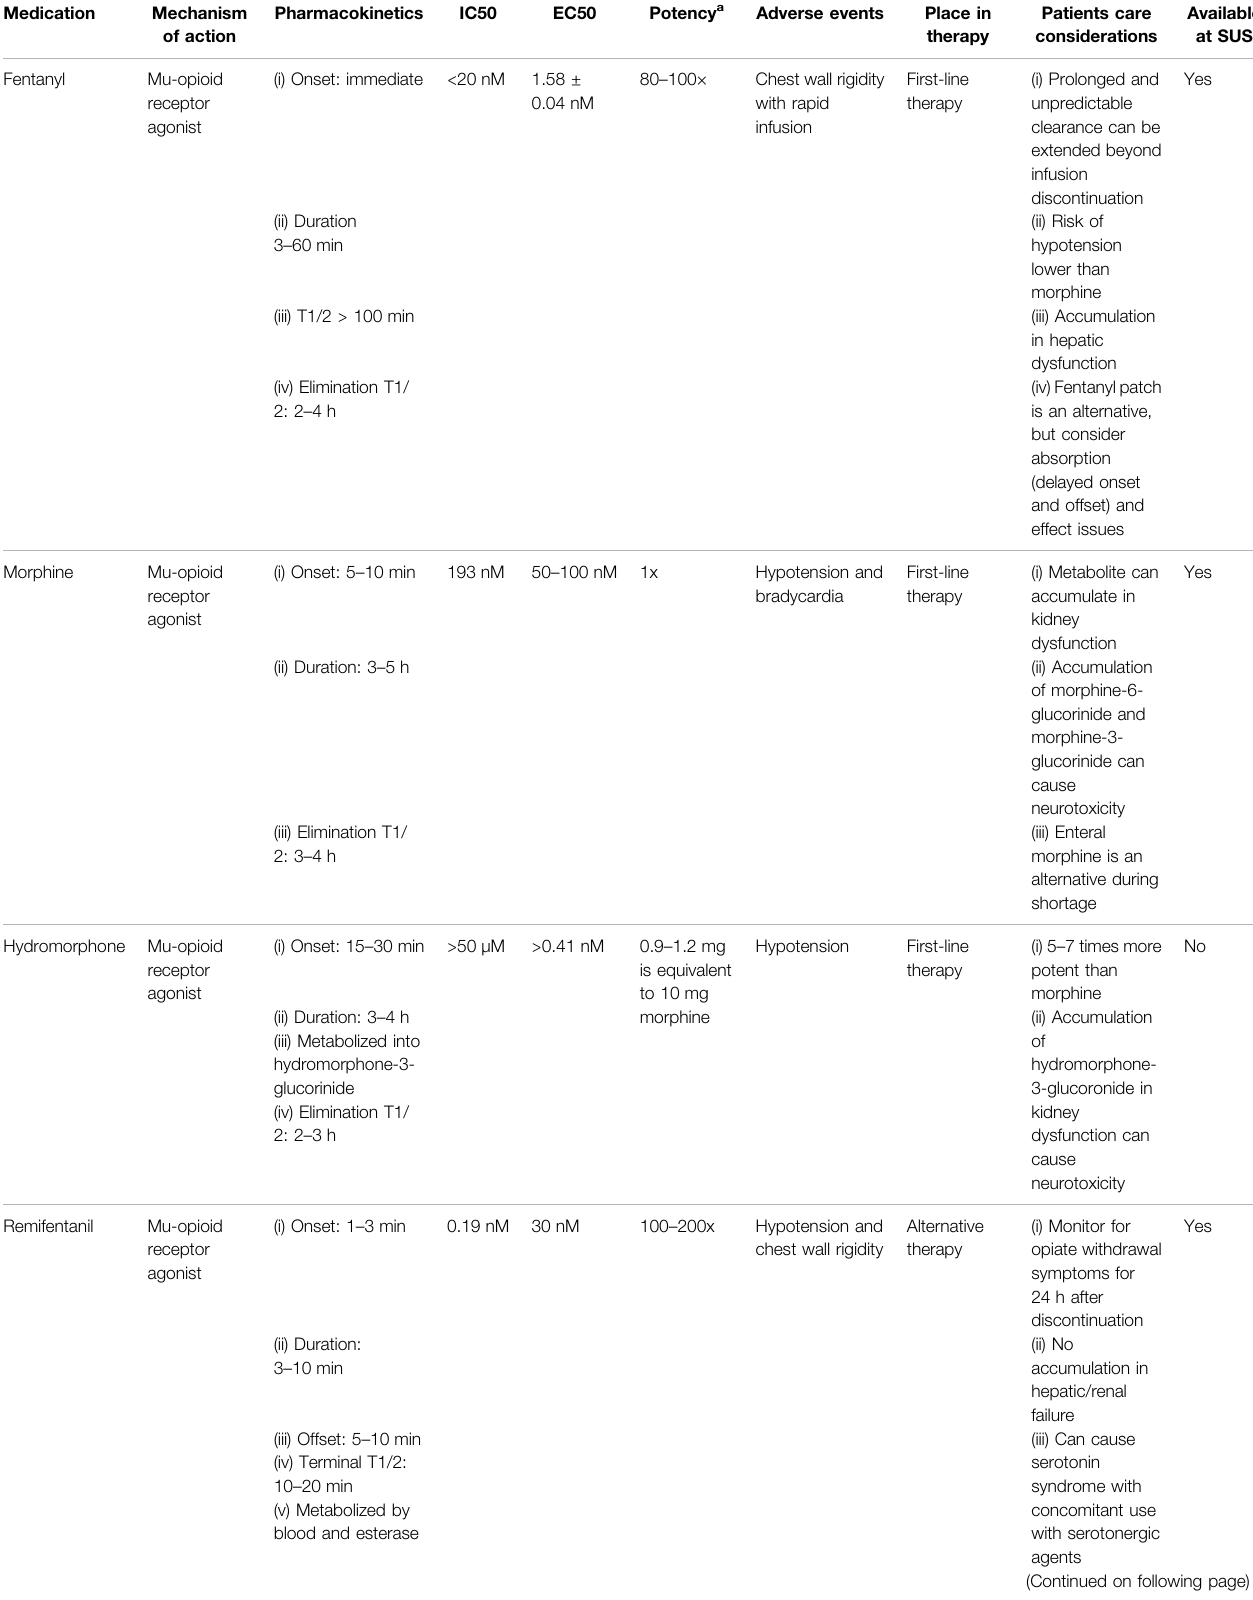
Potency a Adverse events Place in